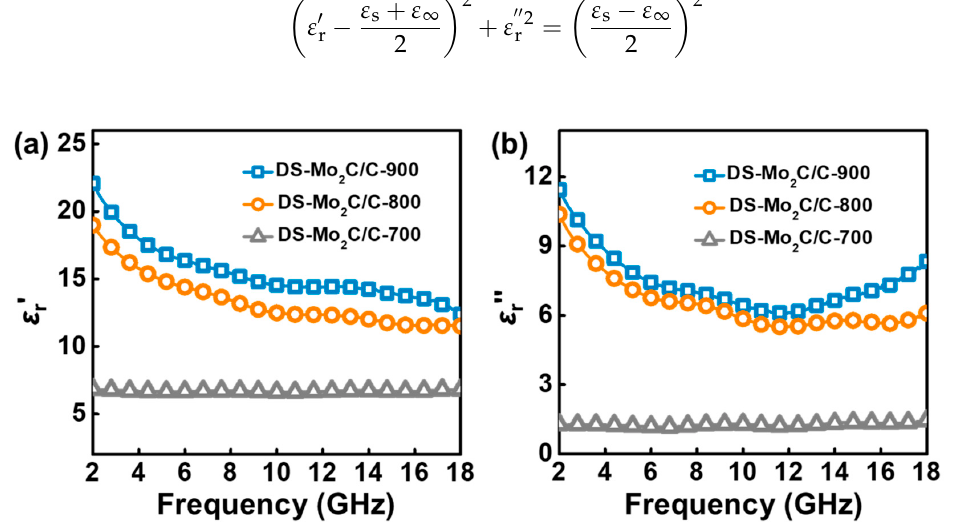
Figure 6. Real parts ( a ) and imaginary parts ( b ) of the complex permittivity of DS − Mo 2 C/C − 700, DS − Mo 2 C/C − 800, and DS − Mo 2 C/C − 900. DS-Mo 2 C/C-800, and DS-Mo 2